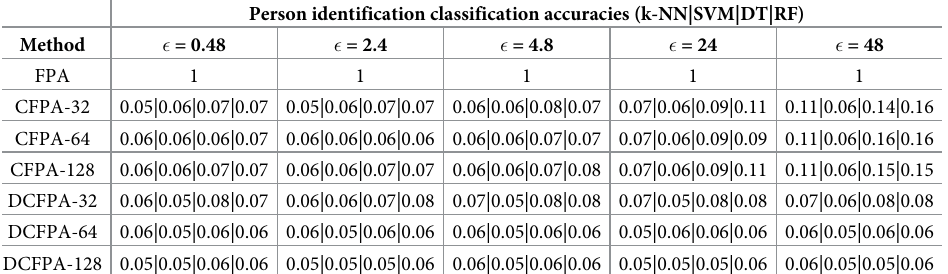
Table 5. Person identification classification accuracies in the MPIIPrivacEye dataset using differentially private eye movement features with majority